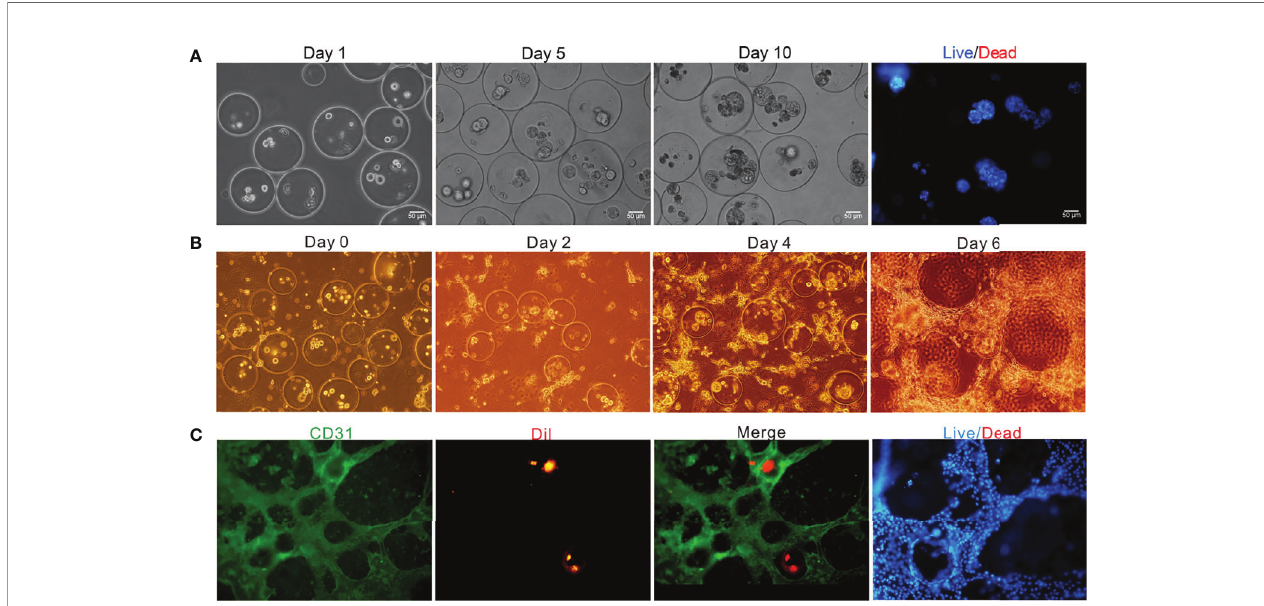
FIGURE 5 | Off-chip and on-chip culture of the bilayer microspheres. (A) Off-chip cell growth in the microspheres as a function of time; (B) Bright fi eld image of the vascularized live microtissue cultured on chip; (C) Fluorescence image of the vascularized live microtissue cultured on